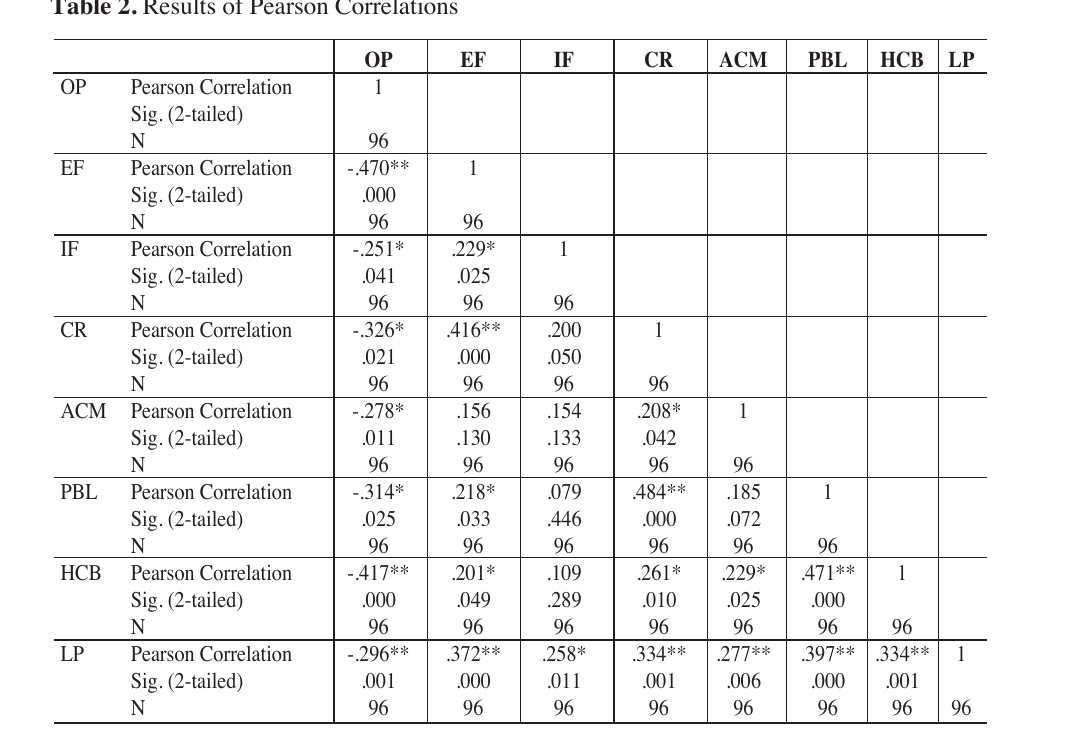
Table 2. Results of Pearson